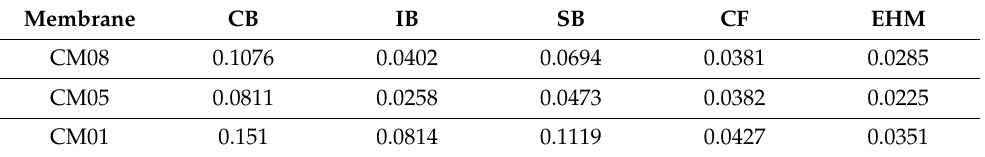
Table 5. RMSE results obtained in Example 2 for CM08, CM05, and CM01. Membrane